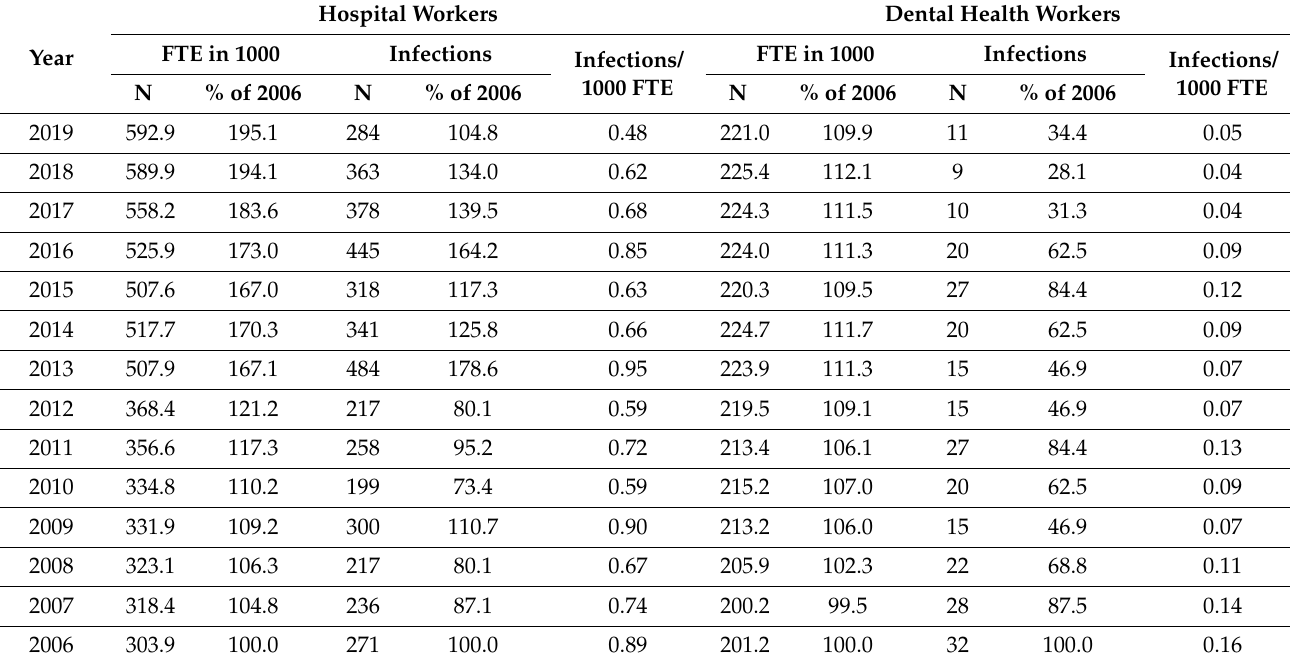
Table 2. Full-time equivalents (FTE), claims of infection and rate of infections per 1000 FTE for 2006 to 2019 in hospital workers and dental health workers.